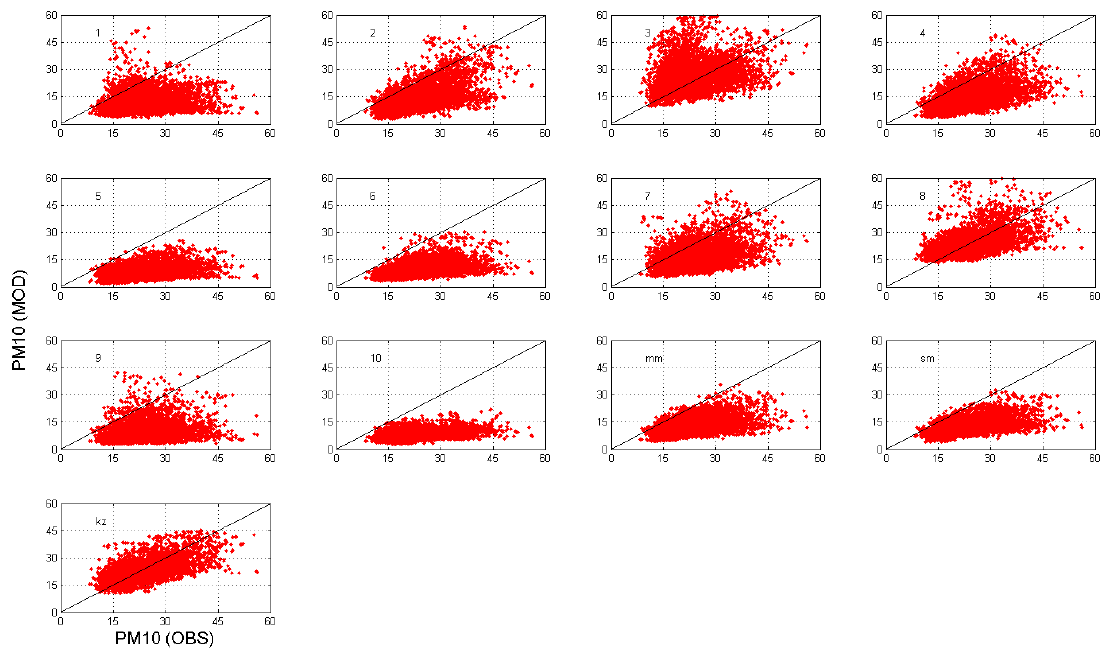
Fig. 16. Indicative results for PM 10 . Scatterplot of all examined cases corresponding to the prediction week, for the rural concentrations of the EU1